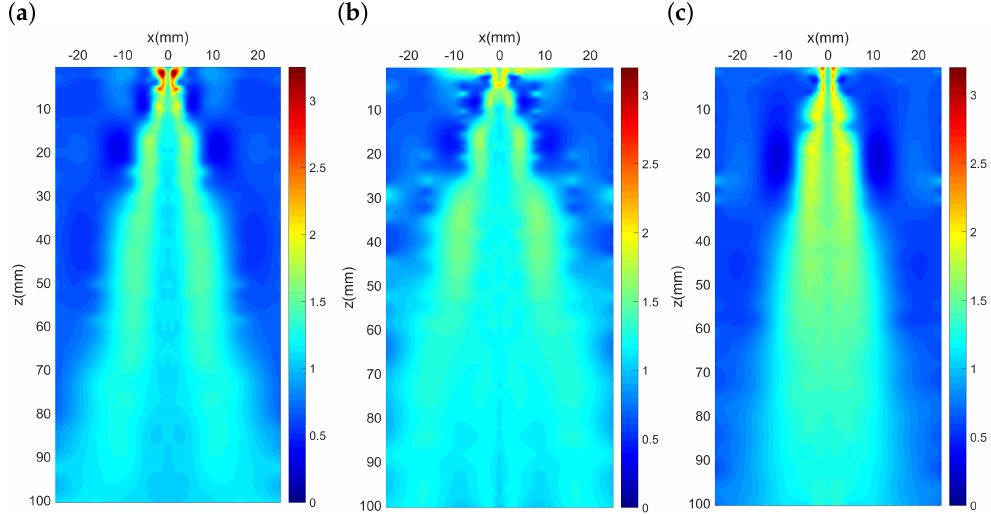
Figure 8. Distribution plots of temperature fluctuation intensity (TFI): ( a ) Original nozzle, ( b ) nozzle with outer-director, and ( c ) nozzle with